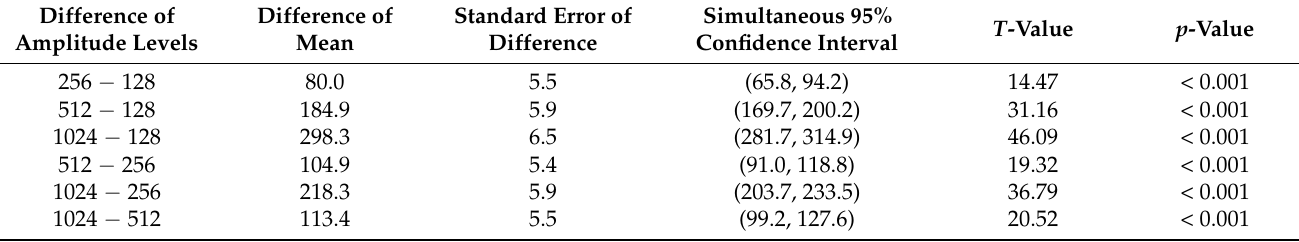
Table 6. Tukey simultaneous tests for differences of means in amplitude. The larger the amplitude was, the longer the MT was.